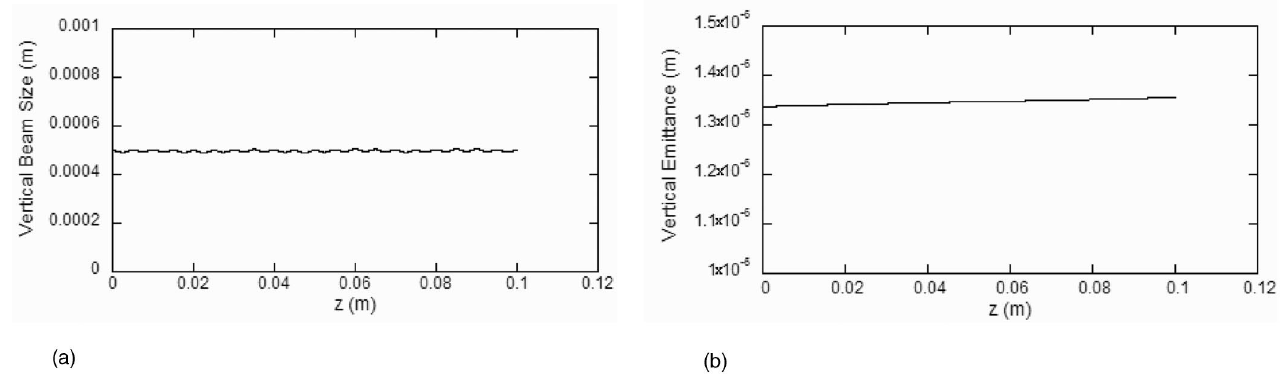
distance.FIG. 3. (a) 4-times y beam size versus axial distance for the nominal PPM transport. (b) Normalized vertical emittance versus rms axial distance for the nominal PPM transport.